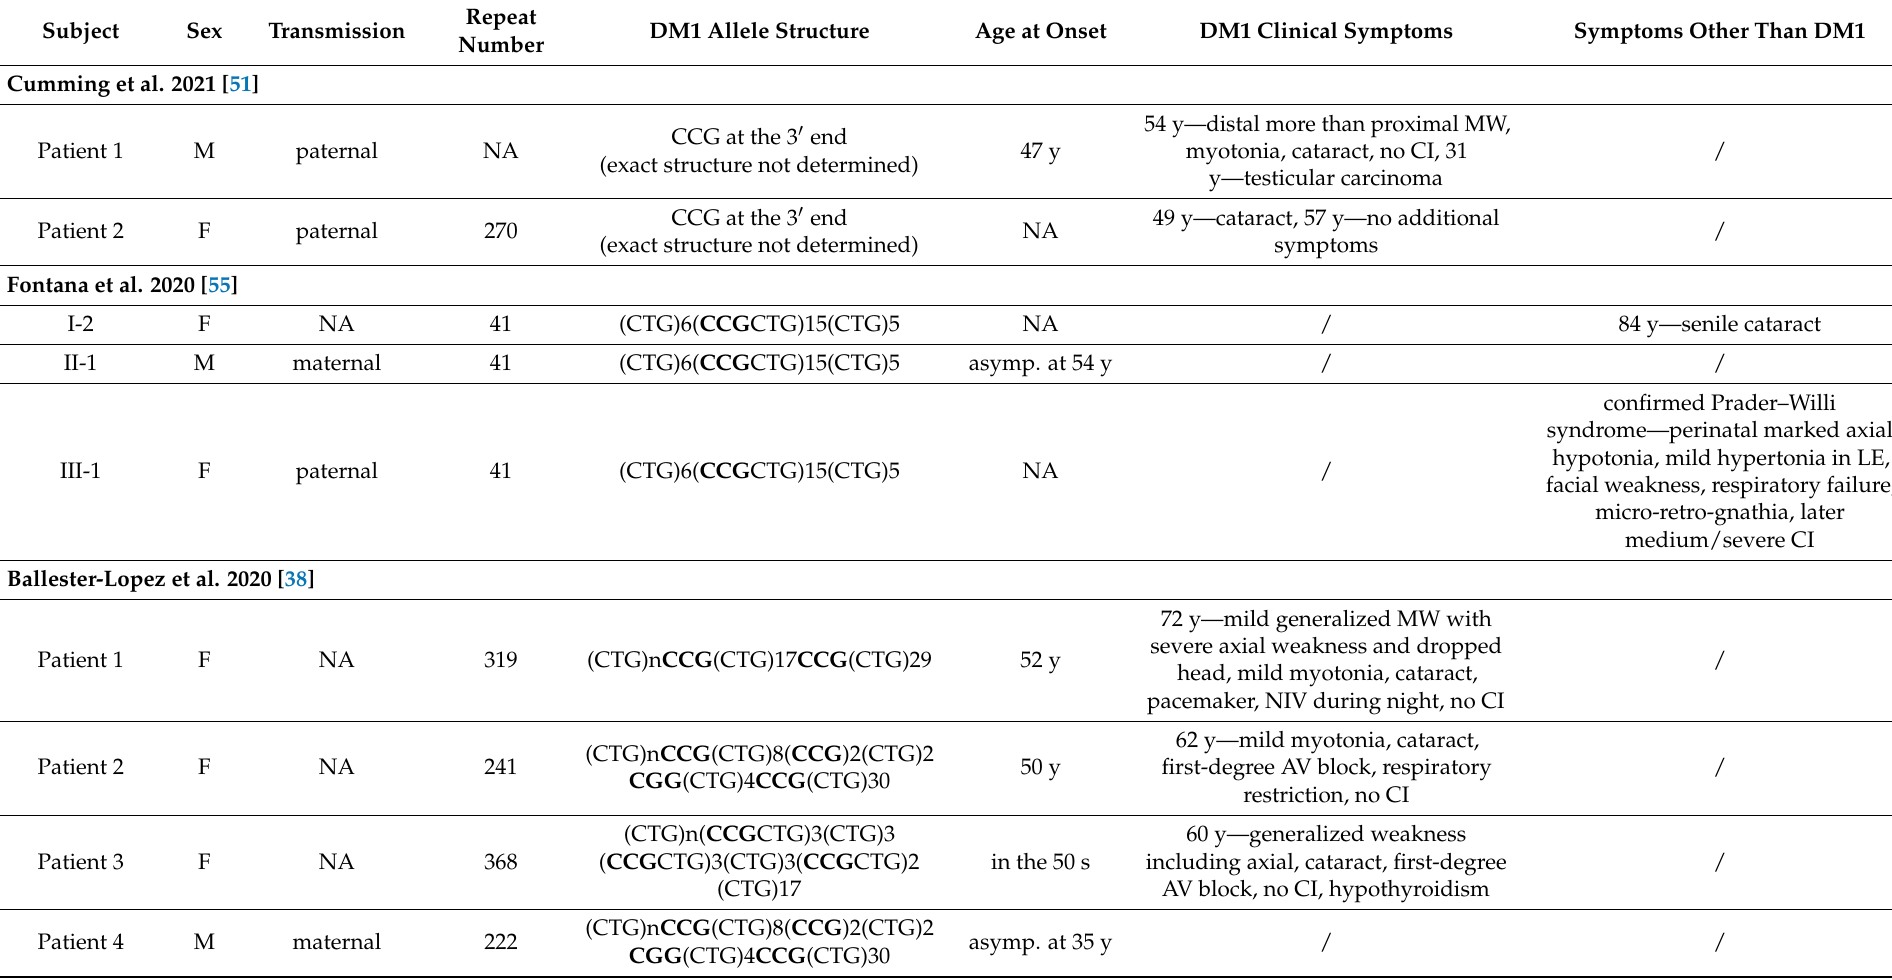
Table 1. Genetic and phenotypic features of subjects with variant repeats in the DMPK (CTG)n array reported in the